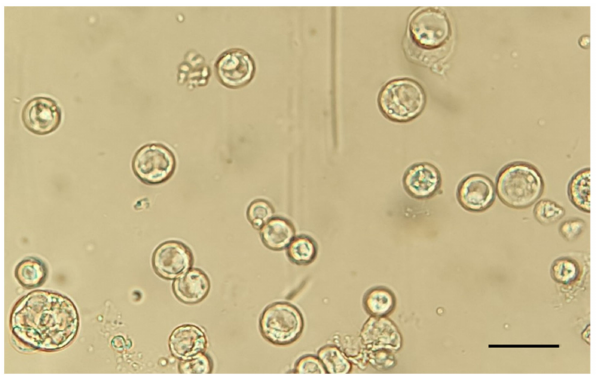
Figure 1. Extracted protoplasts. Magnification 40 × . Scale bar = 100 µ